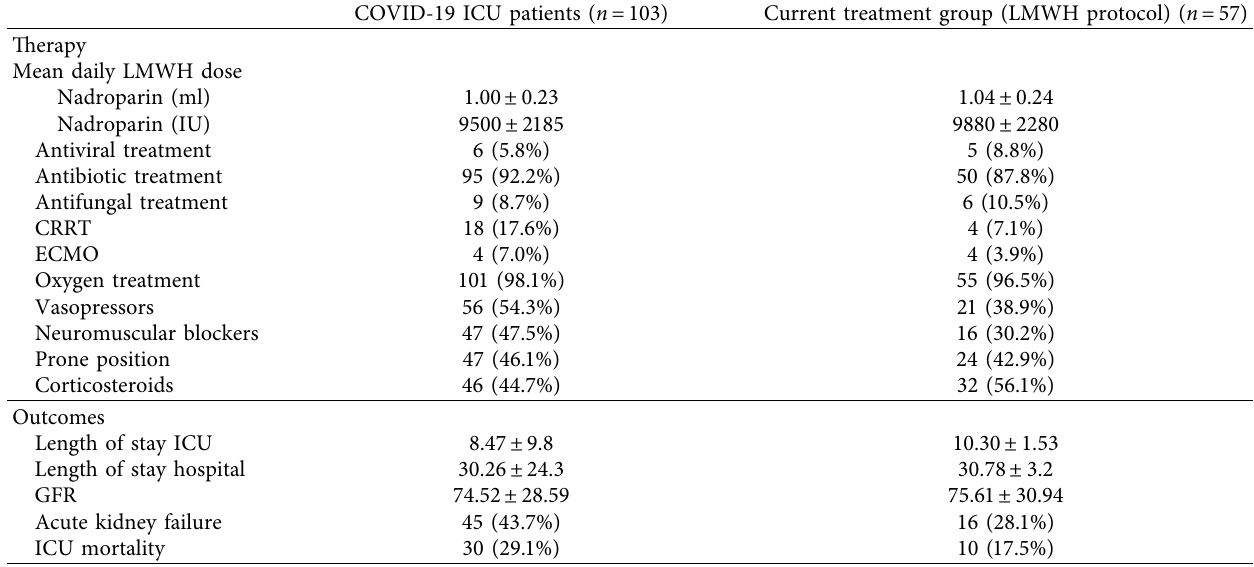
Table 2: Therapy and outcomes.